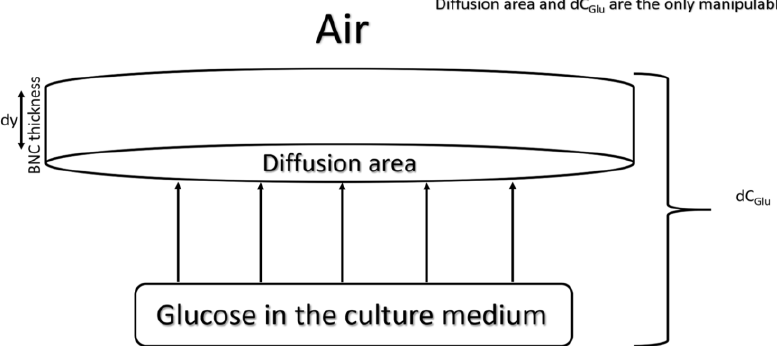
Figure 1. Glucose diffusion phenomenon through the BNC membrane and the effect of the glucose concentration and V/A ratio on the BNC production yield.